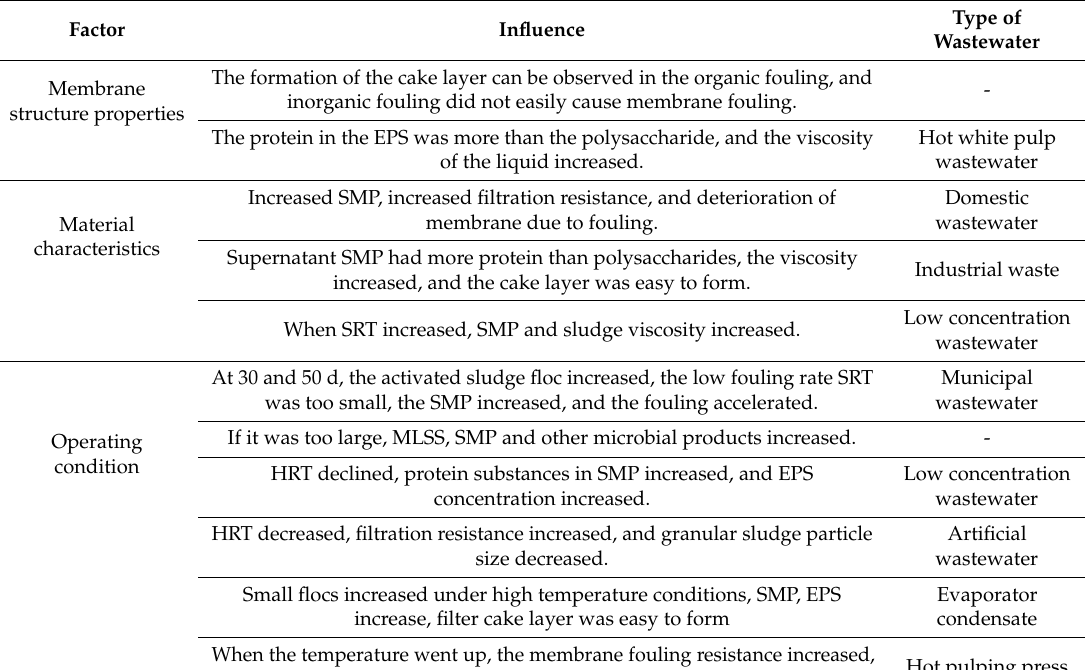
Table 2. Factors a ff ecting membrane